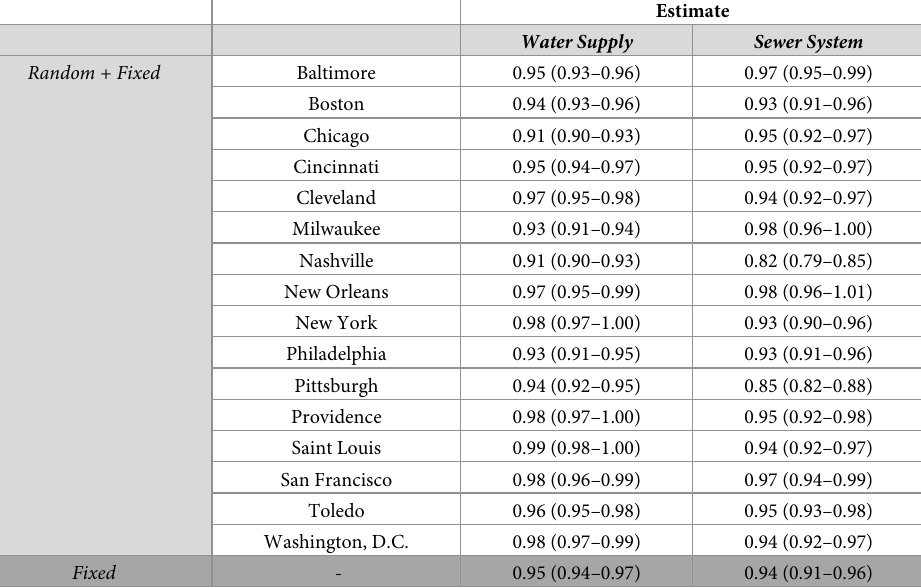
Table 3. Results of hierarchical regression analyses for overall investment variables: Random and fixed effects for yearly average long-term typhoid transmission vs. overall investments in water and sewer systems. Each estimate shows the associated multiplicative change in the estimated long-term typhoid transmission rate for each $1 per capita increase in overall investment for the water supply and sewer system (in 1931 US dollars). Both random and fixed effects are shown, with their 95% confidence